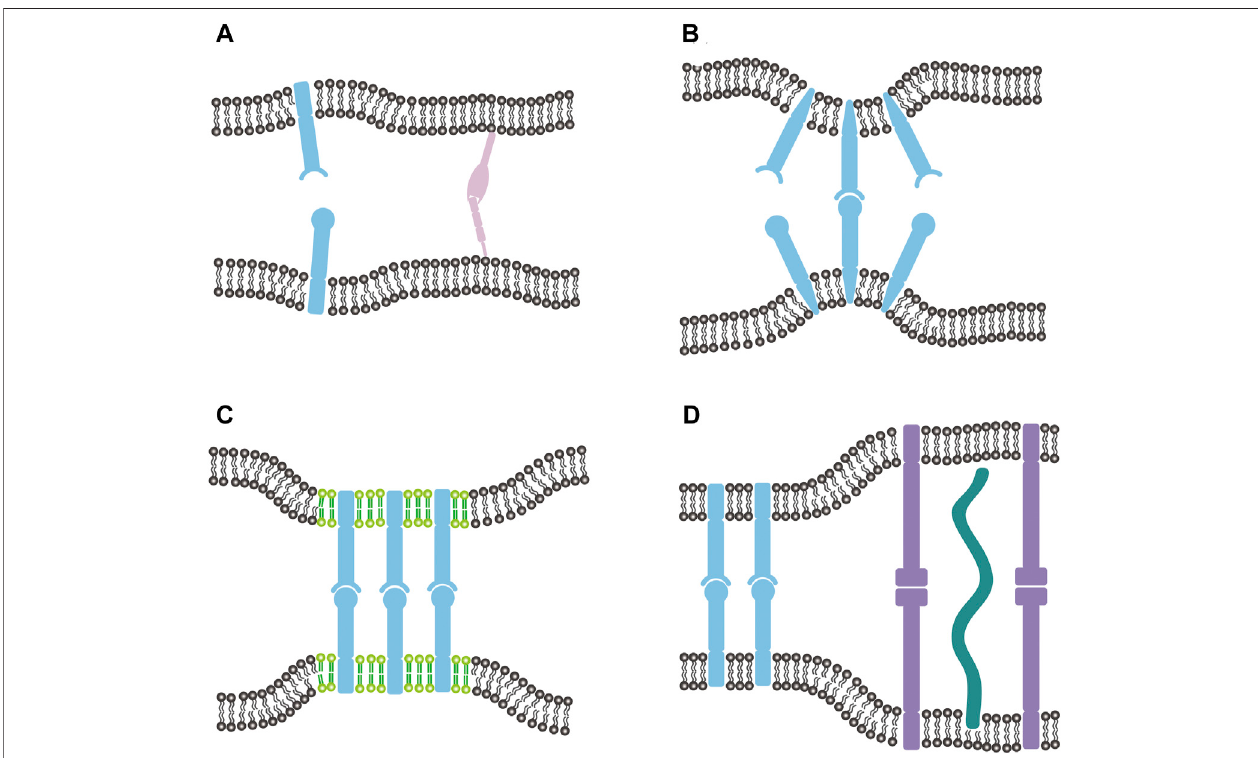
FIGURE 1 | (A) Two fl uctuating membranes adhering via speci fi c binding of transmembrane (light blue) and lipid-anchored (light purple) receptor and ligand proteins. Both the thermal shape fl uctuations of membranes, which change the average membrane separation and relative membrane roughness, and the anchoring energy affect the receptor-ligand binding kinetics. (B) Wedge-shaped transmembrane proteins bend their associated membranes to induce membrane curvature. The local curvatures induced by receptor and ligand affect their binding kinetics by 1) altering the local separation and relative roughness of the two apposing membranes and 2) causing protein-protein cis -repulsion on each membrane. (C) Preferential partitioning of membrane-anchored receptors and ligands in the lipid rafts (light green) enhances the binding af fi nity of those proteins, which can be partially attributed to the entropy gain of the membranes resulting from raft-induced protein aggregation. (D) Adhering membranes linked via two types of membrane-anchored receptors and ligands with different lengths in the presence of glycocalyx (dark green). The difference in lengths between the shorter and longer receptor-ligand complexes, on the one hand, forms a steric barrier for the complex formation, on the other hand, facilitates protein aggregation to enhance binding. These two competing effects are additionally regulated by the presence of glycocalyx.